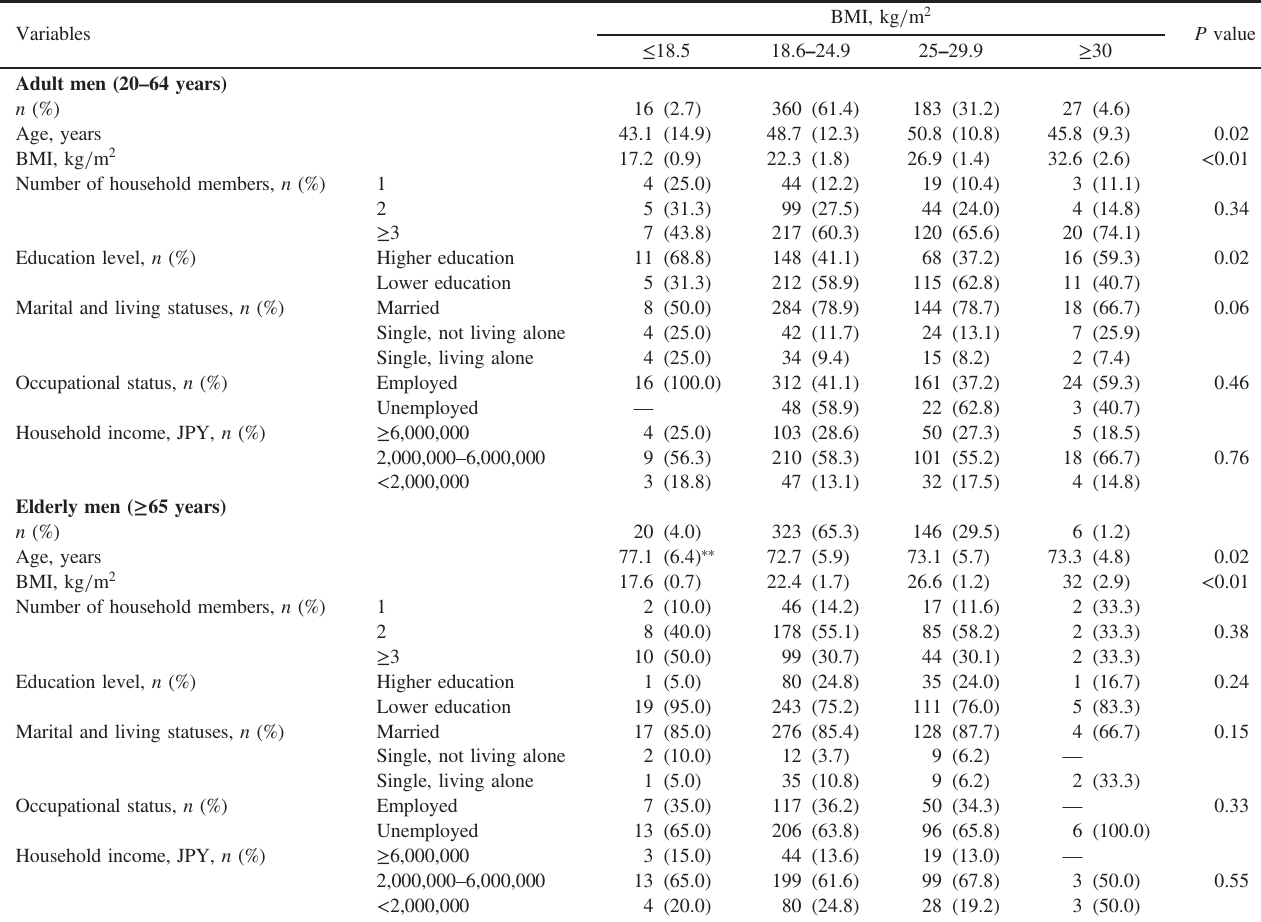
Table 1. Background characteristics according to BMI categories in men (NIPPON DATA2010)